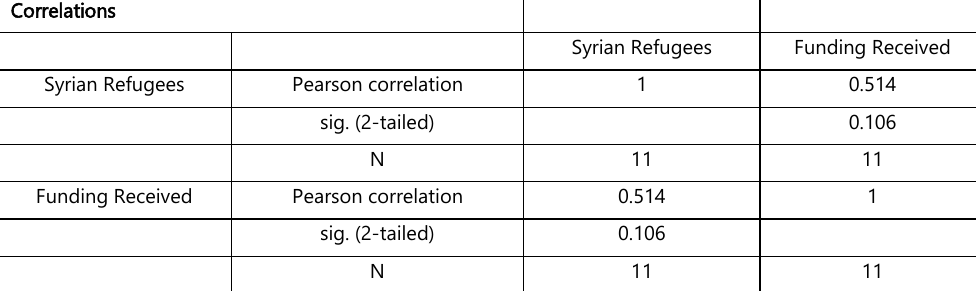
Table 2: Correlation Analysis (Source: Author‘s research 2022 )